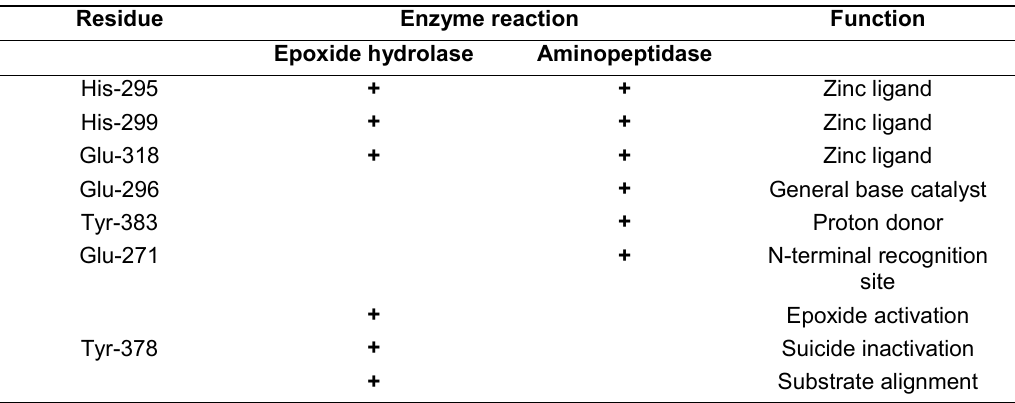
Functional Residues in LTA4